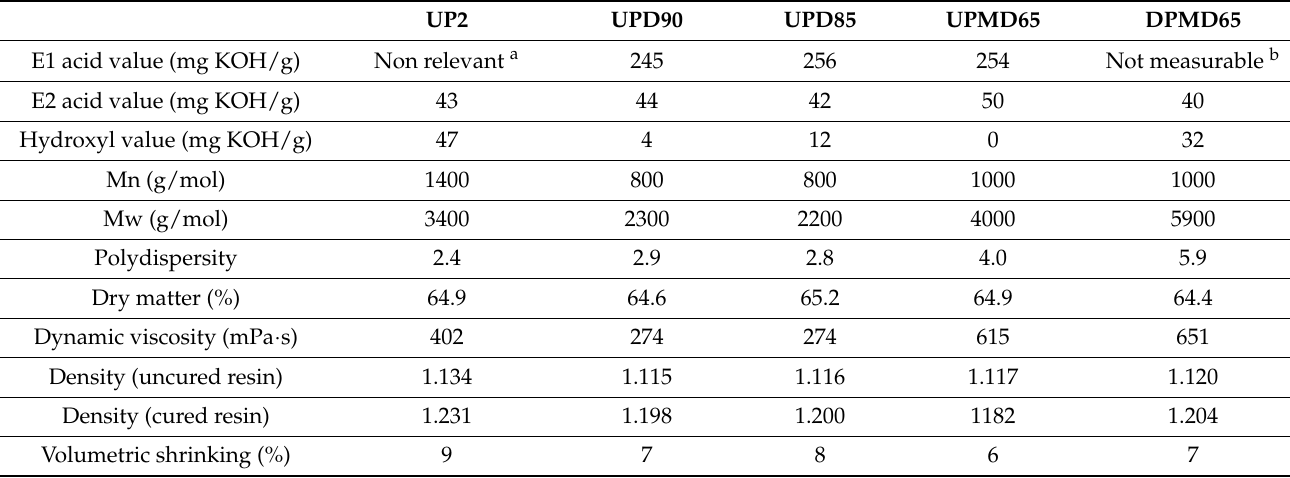
Table 9. Basic UPR